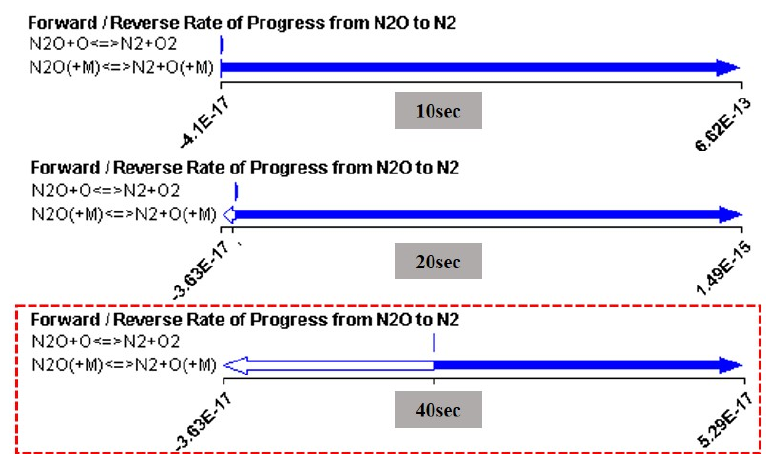
3 s) at 1013 and 1113 K. 2 O to N 2 (M/cm